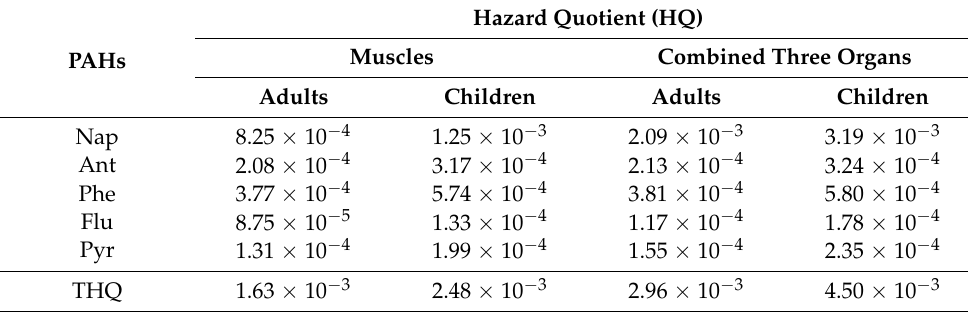
Table 5. Hazard quotient (HQ) for non-carcinogenic effect.